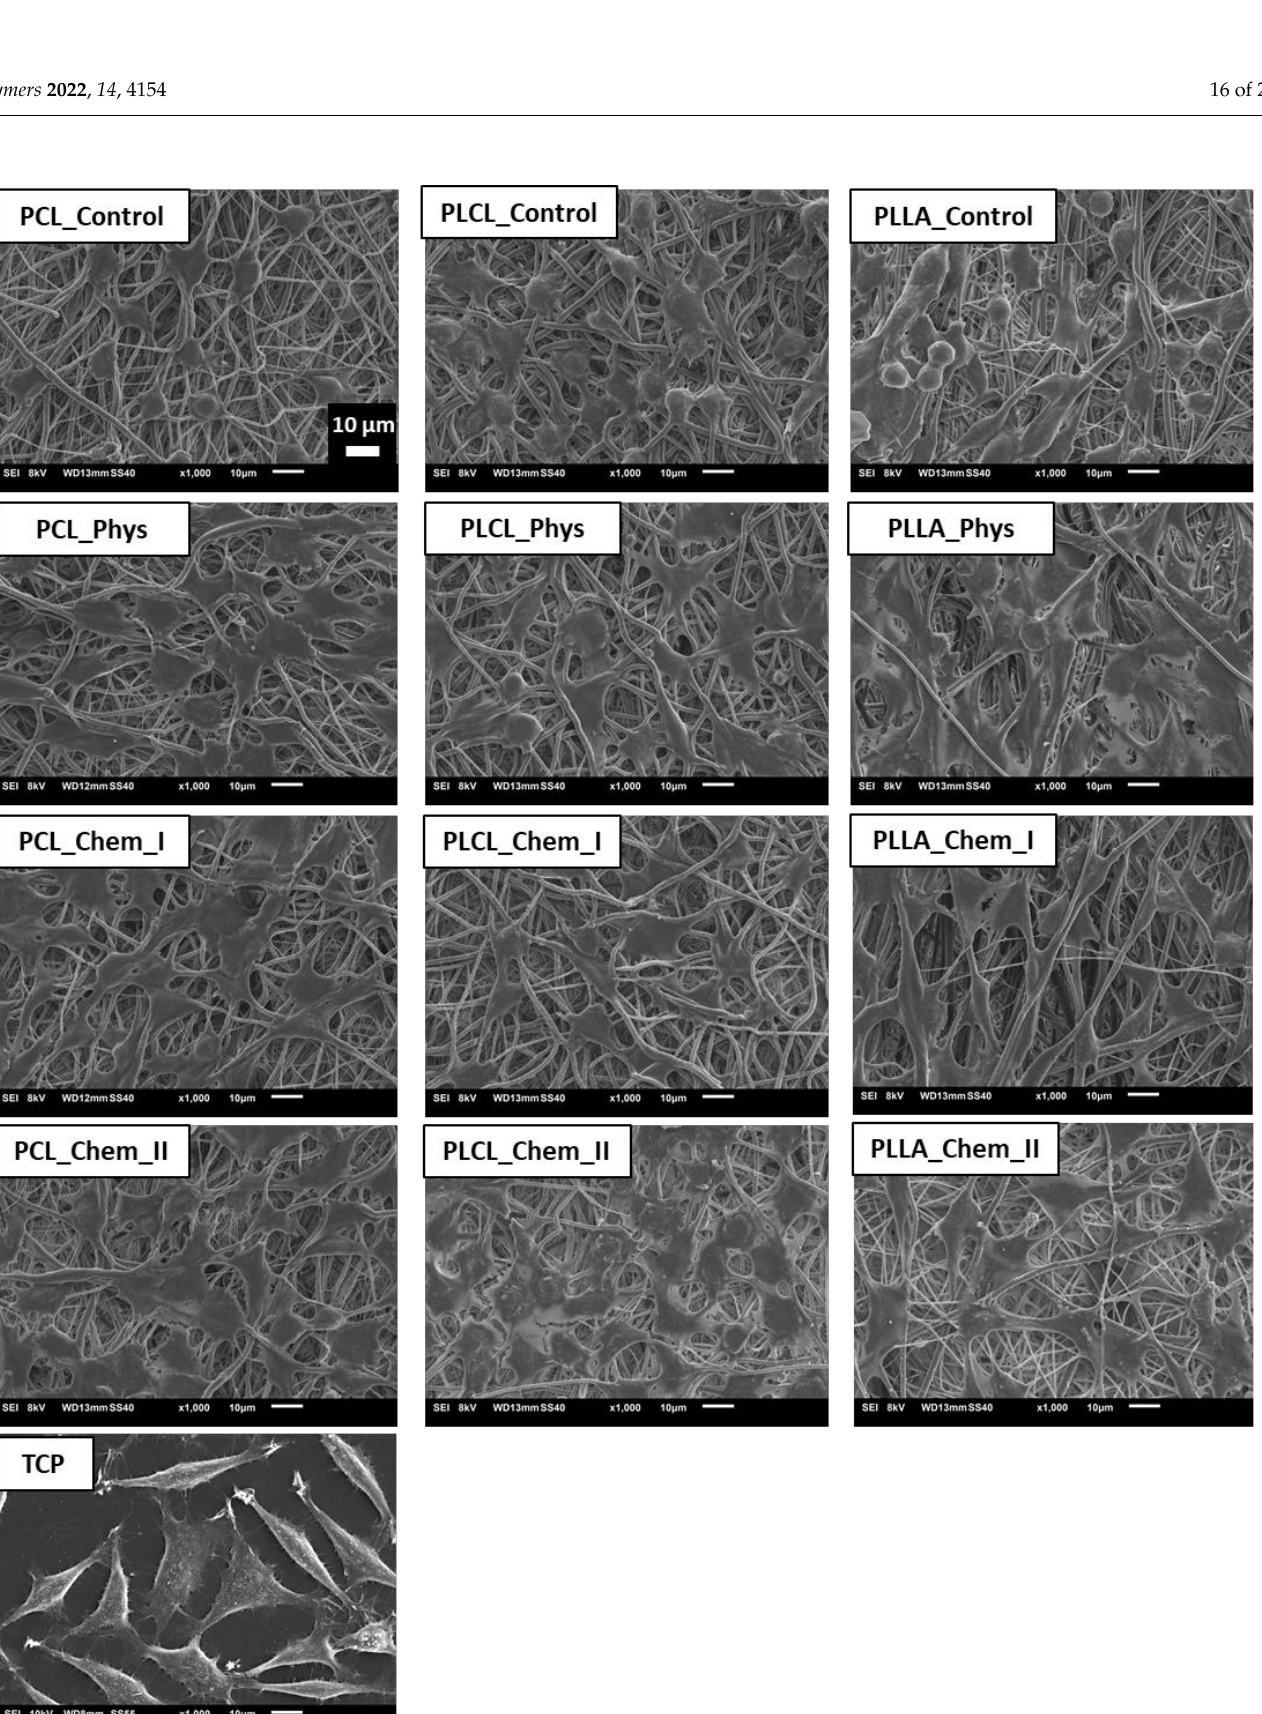
Figure 8. L929 cells cultured for 5 days on control and gelatin-coated samples observed with scanning electron microscopy.